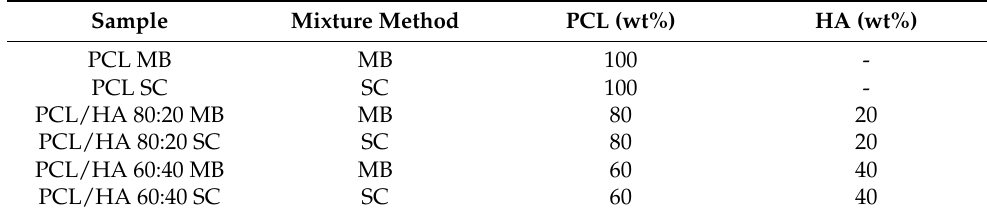
Table 8. Composition of the prepared